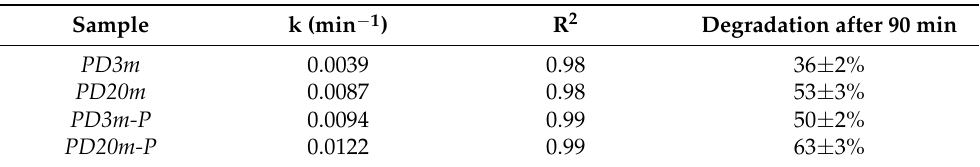
Table 5. The kinetic constants, R 2 , and degradation achieved after 90 min of UV irradiation of the different coatings.